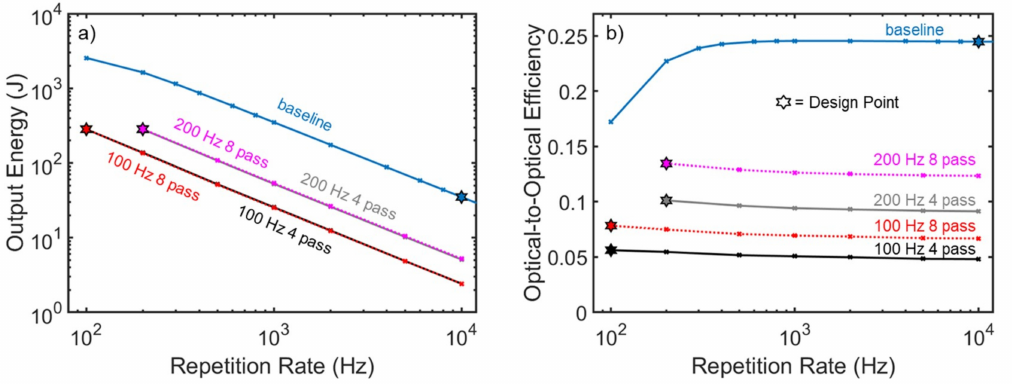
Figure 5. ( a ) Available output energy from EuPRAXIA amplifier designs as it is operated at di ff erent repetition rates when tuned at constant average power. The energy tuning curves for the 4-pass and 8-pass versions of the designs are nearly indistinguishable. ( b ) Optical-to-optical e ffi ciency of designs as a function of repetition rate. The ‘baseline’ design is the 10 kHz, 100 fs, 30 J design described in [20].